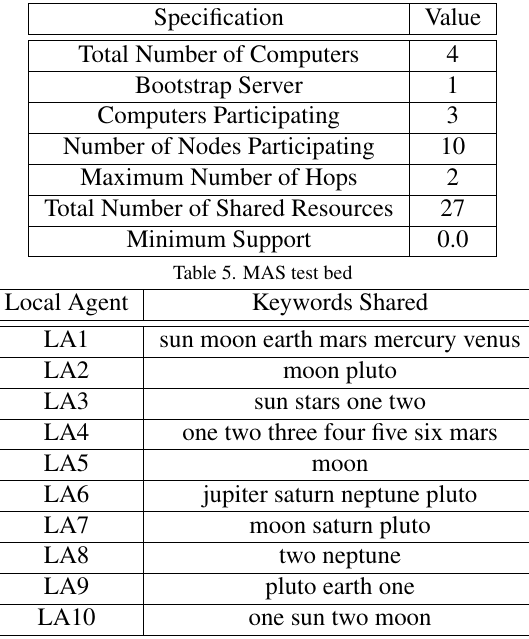
Table 6. Keywords used for sharing resource on each